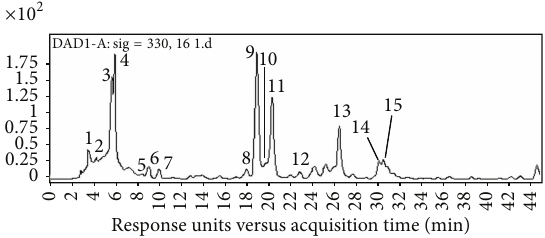
Figure 1: HPLC chromatogram of the ethanol extract of H. tuberosus leaves detected at 330 nm. Peak numbers were consistent with those shown in Table